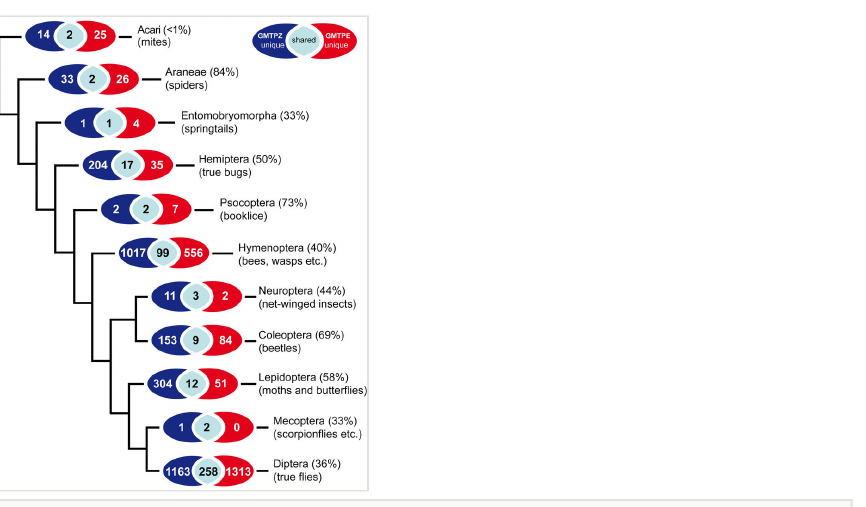
(Fig. 3). The greatest proportion of unique BINs was observed in the May sample from GMTPE with 238 BINs (47.9%) not observed in any other month. In the other trap there was a peak of unique BINs in July, with 644 BINs (42.3%) not detected in any other month in GMTPZ samples.